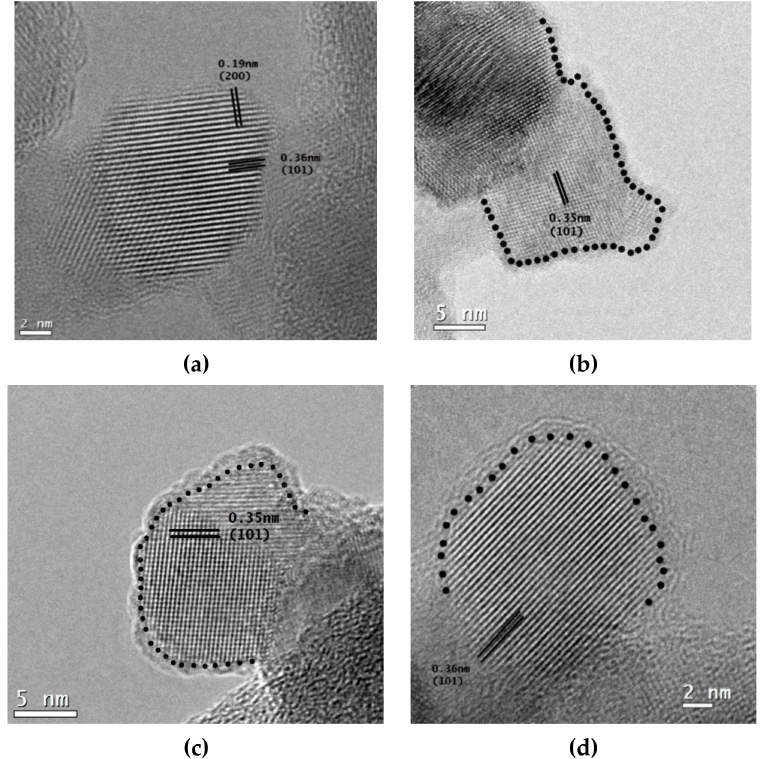
Figure 4. HRTEM images of TiO 2 nanocrystals: ( a ) P25 TiO 2 before reduction, ( b ) TiO 2red 30 (1.2 nm of the amorphous layer), ( c ) TiO 2red 50 (1.5 nm of the amorphous layer), and ( d ) TiO 2red 70 (2.0 nm of the amorphous